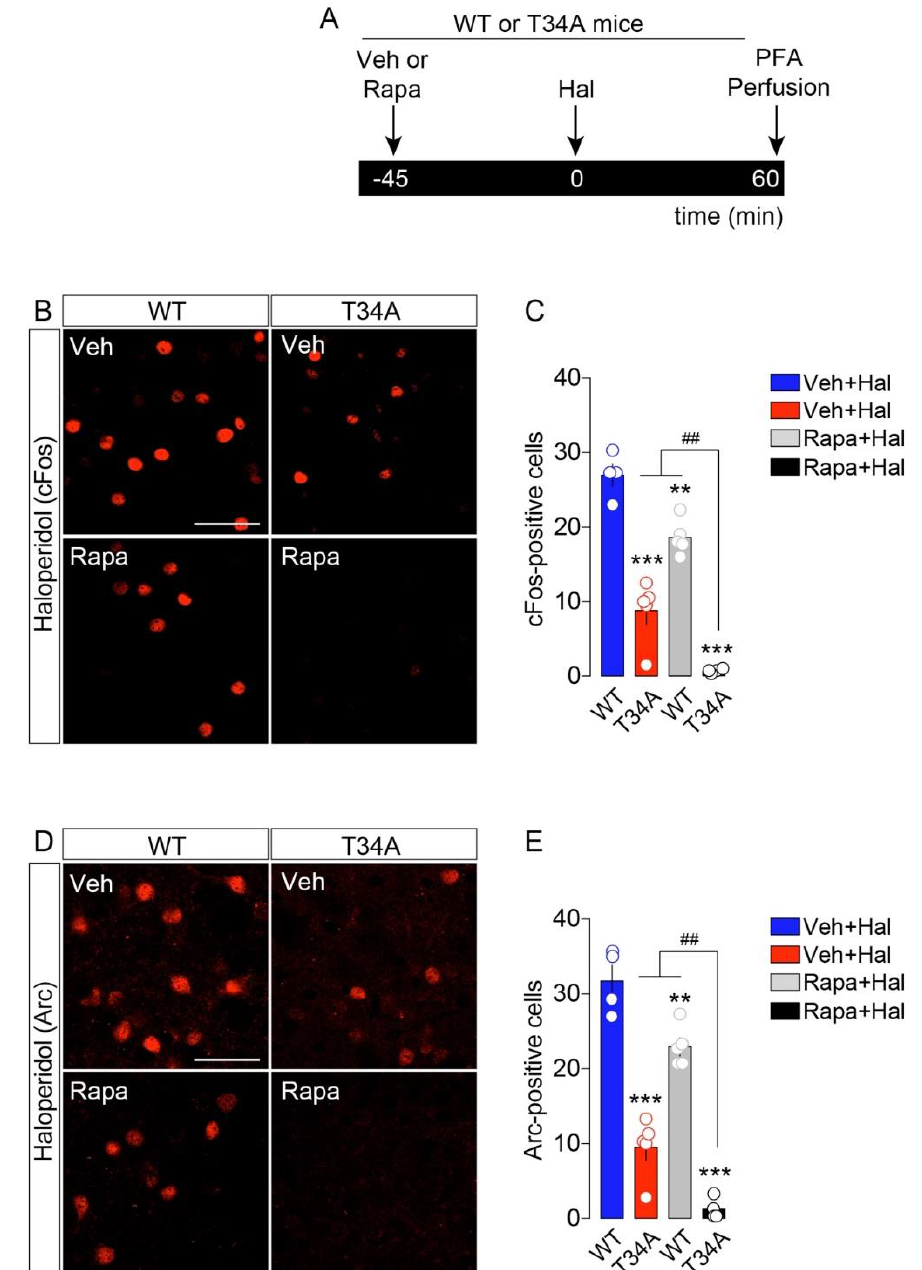
Figure 4. Haloperidol-induced cFos and Arc require the intracellular activation of PKA/DARPP-32 and mTOR pathways. ( A ) Temporal schedule of pharmacological treatments. ( B,D ) Immunofluorescence detection of cFos ( B ) and Arc ( D ) in the striatum of WT and T34A animals treated with vehicle + haloperidol, or rapamycin + haloperidol. Scale bars: 50 μm. ( C ) Quantification of cFos + -neurons in WT and T34A mutant mice treated with vehicle + haloperidol and rapamycin + haloperidol ( n = 4 – 5/group). Statistics: ** p < 0.01 and *** p < 0.001 (T34A + Hal, WT + Rapa + Hal, T34A + Rapa + Hal vs. WT + Hal), ## p < 0.01 (T34A + Rapa + Hal vs. T34A + Hal and WT + Rapa + Hal). One-way ANOVA: F (3, 14) = 62.67, p < 0.0001. ( E ) Quantification of Arc + -neurons in WT and T34A mutant mice treated with vehicle + haloperidol and rapamycin + haloperidol ( n = 4 – 5/group). Statistics: ** p < 0.01 and *** p < 0.001 (T34A + Hal, WT + Rapa + Hal, T34A + Rapa + Hal vs. WT + Hal), ## p < 0.01 (T34A + Rapa + Hal vs. T34A + Hal and WT + Rapa + Hal). One-way ANOVA: F (3, 14) = 70.07, p < 0.0001.